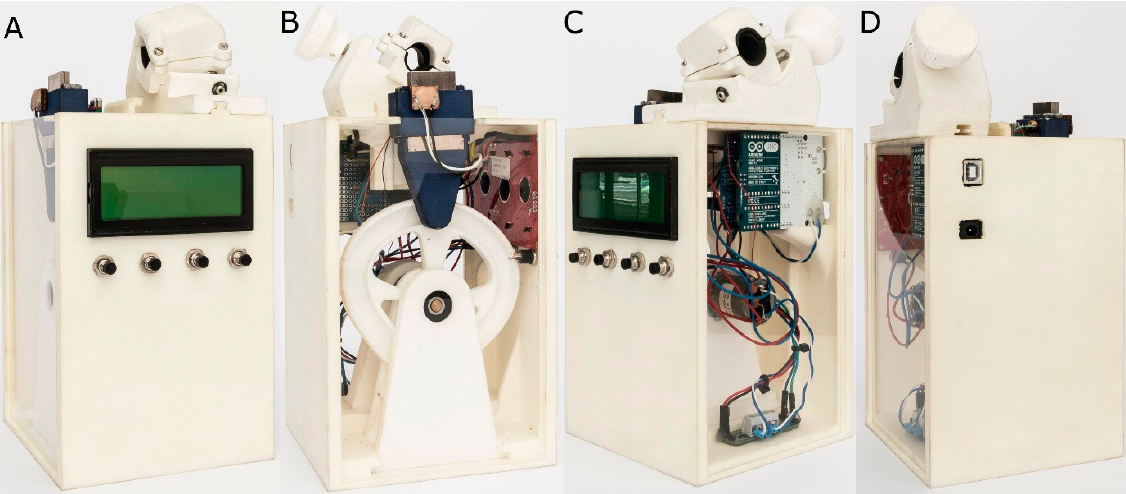
Figure 3. ( A ) Front, ( B ) back, ( C ) right, and ( D ) left surfaces of the dynamic cyclic fatigue device.